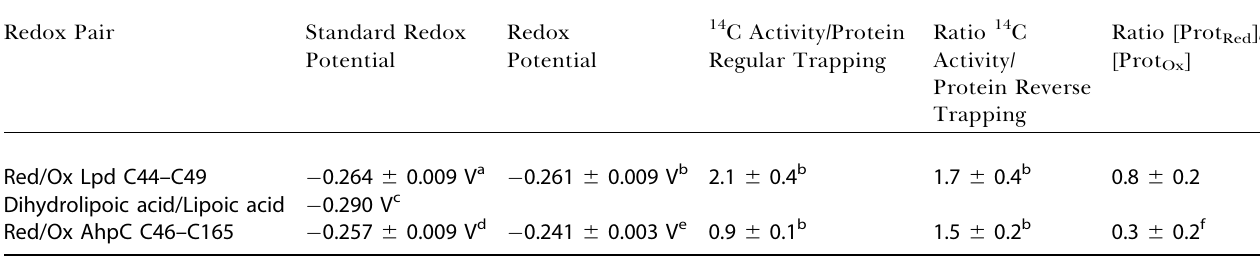
Table 1. Standard Redox Potentials, Redox Potentials, and 14 C Activity/Protein Ratios in the Reverse and Regular Trapping Experiments of Selected Redox Pairs Redox Pair Standard